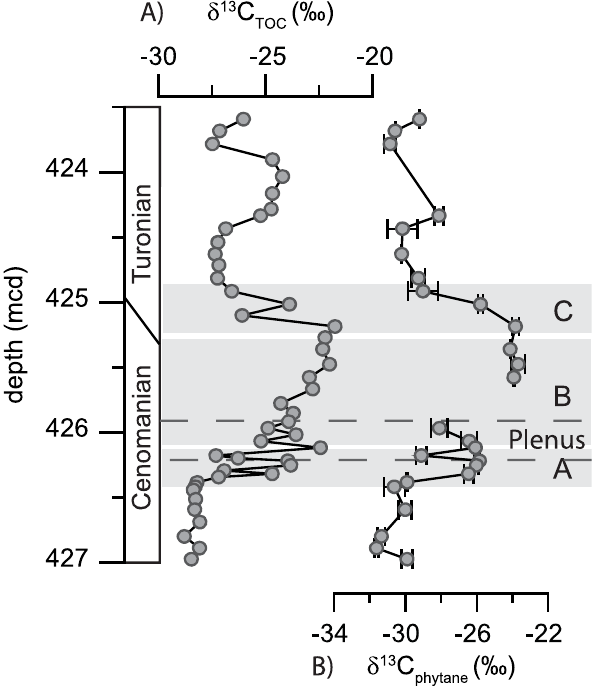
Fig. 2. Stable carbon isotope and biomarker data for OAE-2 at De- merara Rise, ODP Site 1260. (A) isotope values of organic carbon ( δ 13 C TOC ) in ‰VPDB (Forster et al., 2007). (B) isotope values of S-bound phytane ( δ 13 C phytane ) in ‰ VPDB (this study). Grey shaded areas mark phases (A) , (B) and (C) of OAE-2 (see text for details). Scale in meters composite depth